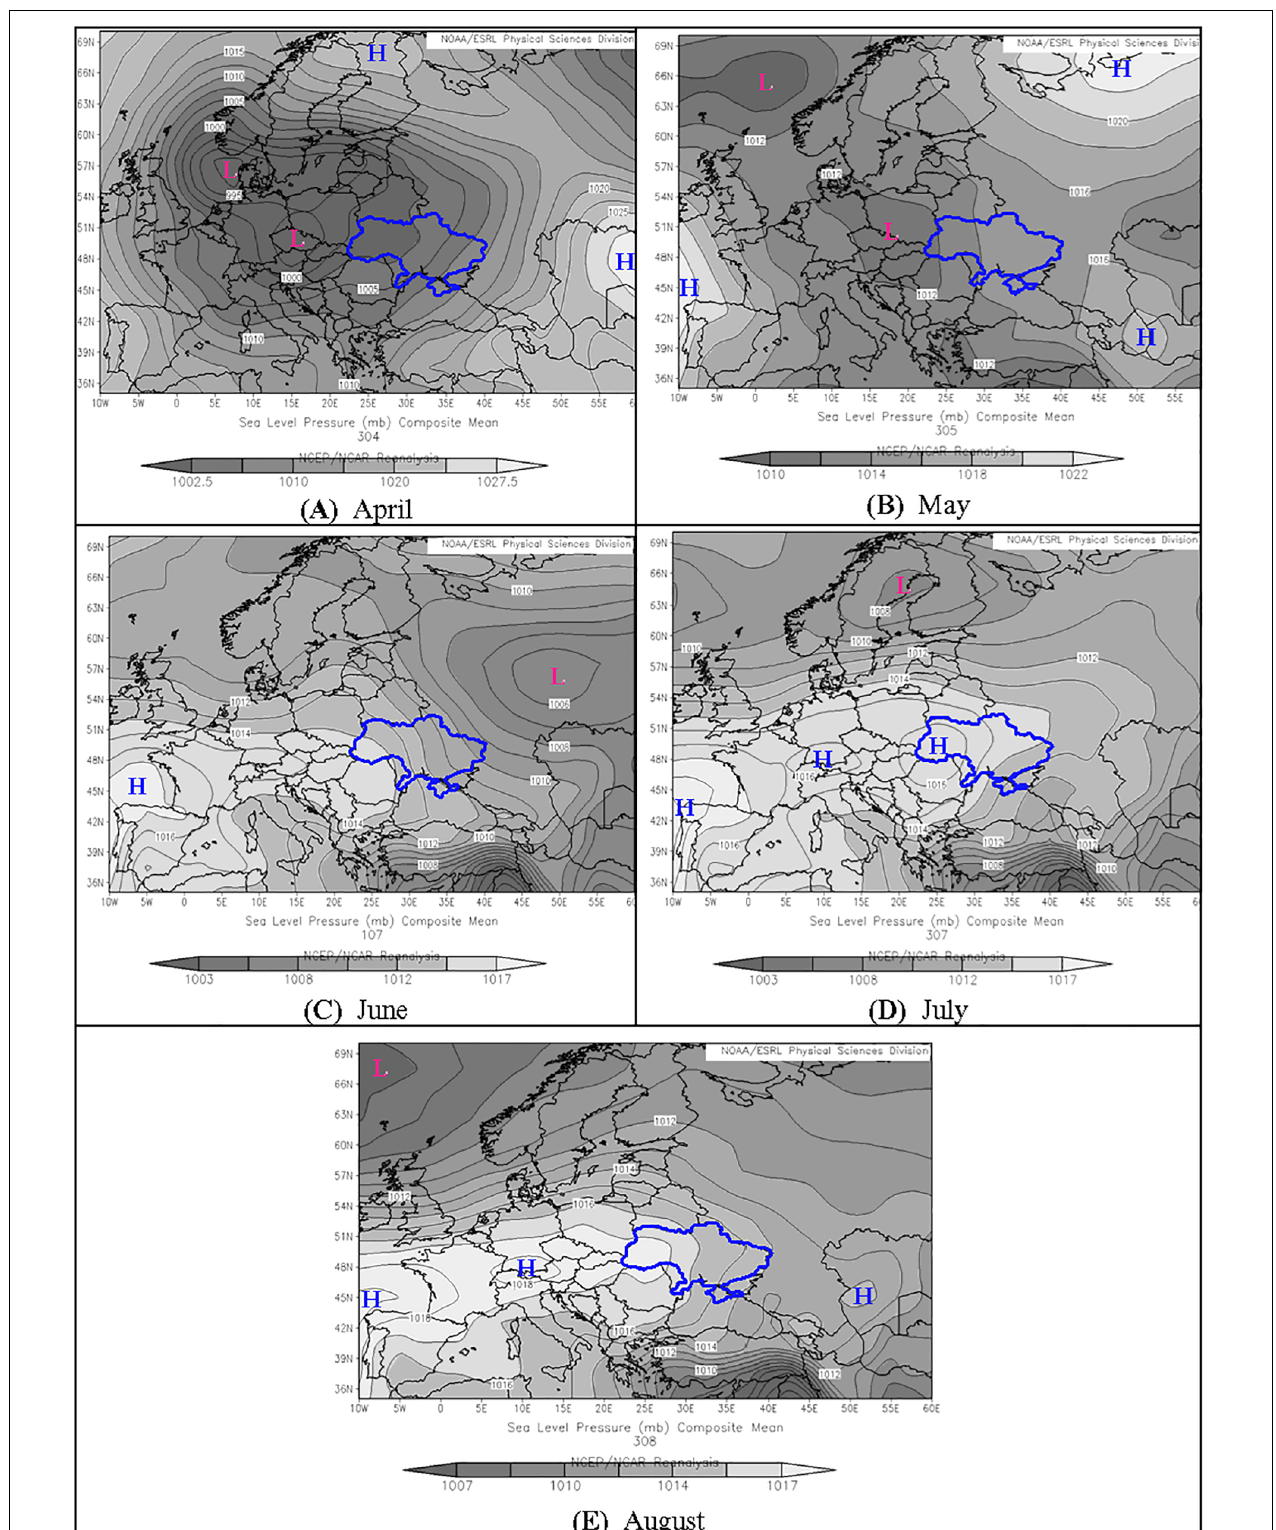
FIGURE 4 | Sea level pressure fields averaged for days with dry winds in the Black Sea Steppe province for the months of warm season (territory of Ukraine is marked). (A) April; (B) May; (C) June; (D) July; (E) August.